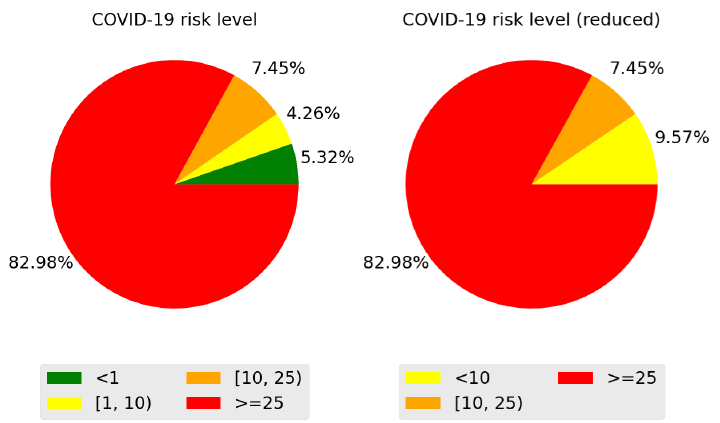
Figure 8. Class distribution of the dataset. Left: HGHI model. Right: HGHI model reduced according to the number of available